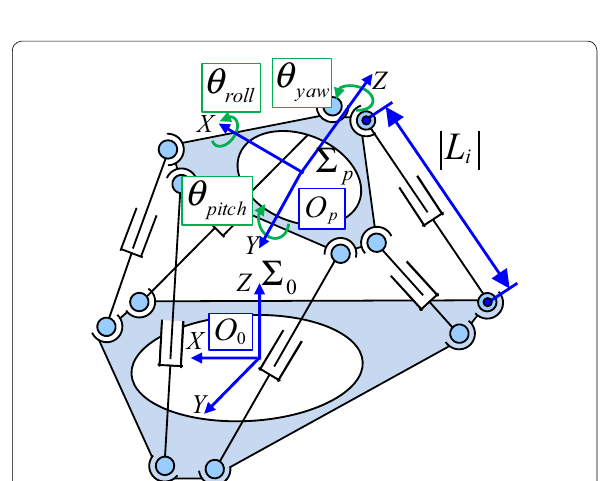
Fig. 5 Variables of the parallel-link model